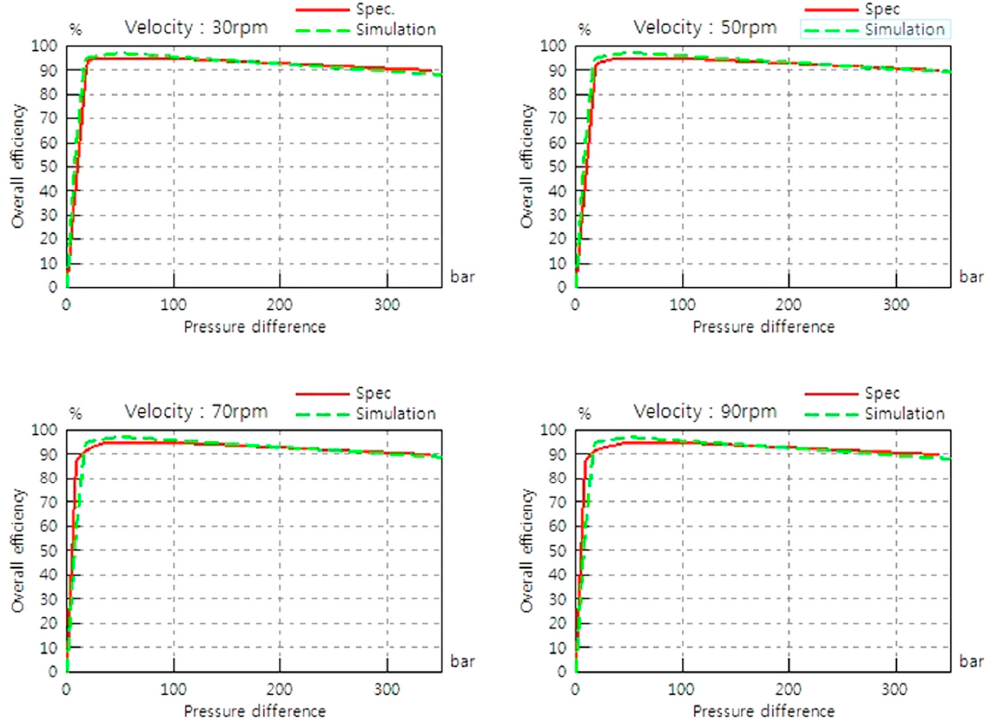
Figure 4. Results of the simulation and test of the hydraulic pump.